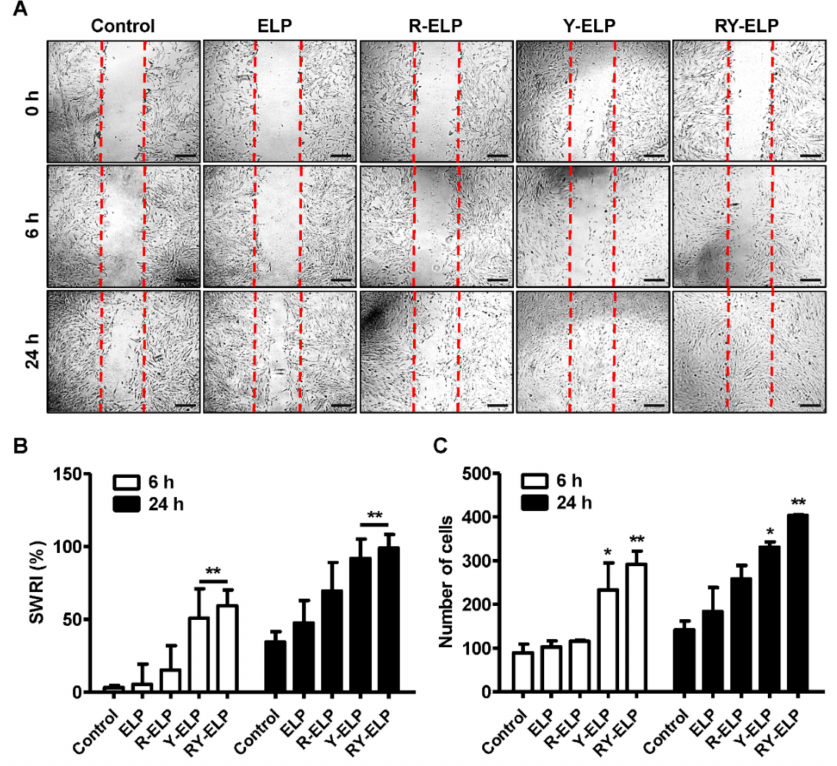
Figure 3. Migration assay of IHF cells. ( A ) Representative phase-contrast images of wounded IHF cells cultured on a fusion-ELP-coated surface as compared with uncoated over a 24-h period ( n = 3), Scale bars: 100 µ m. ( B ) The bar graph represents the percentage of scratch wound recovery index (SWRI). ** p < 0.01 significant difference for Y-ELP and RY-ELP compared with untreated control ( n = 3). ( C ) The number of migratory IHF cells at different time points ( n = 3), * p < 0.05 and ** p < 0.01 significant difference of Y-ELP or RY-ELP compared with uncoated